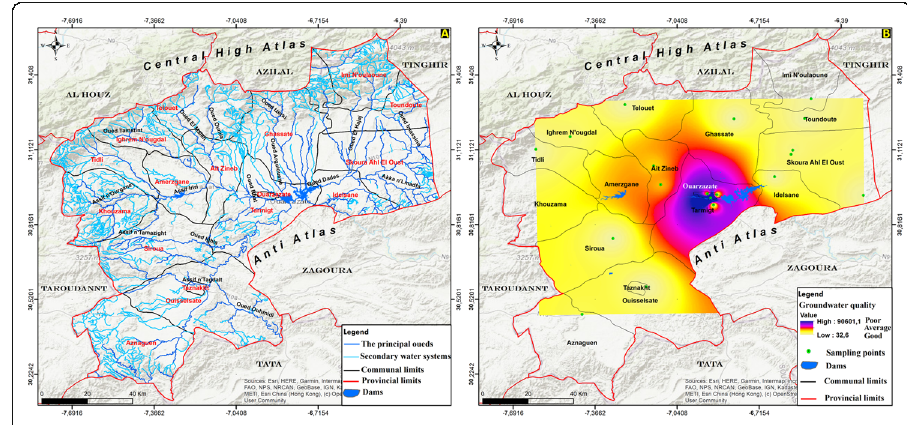
Fig. 6 Map of the hydrographic network of the study area ( A ). Map of the groundwater quality ( B